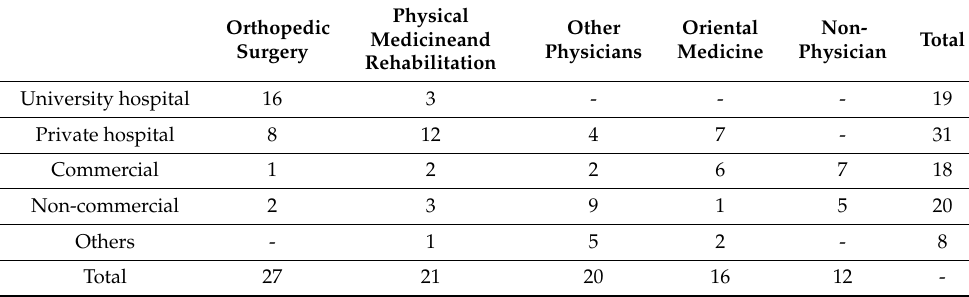
Table 4. Websites classified by authorship and specialty.